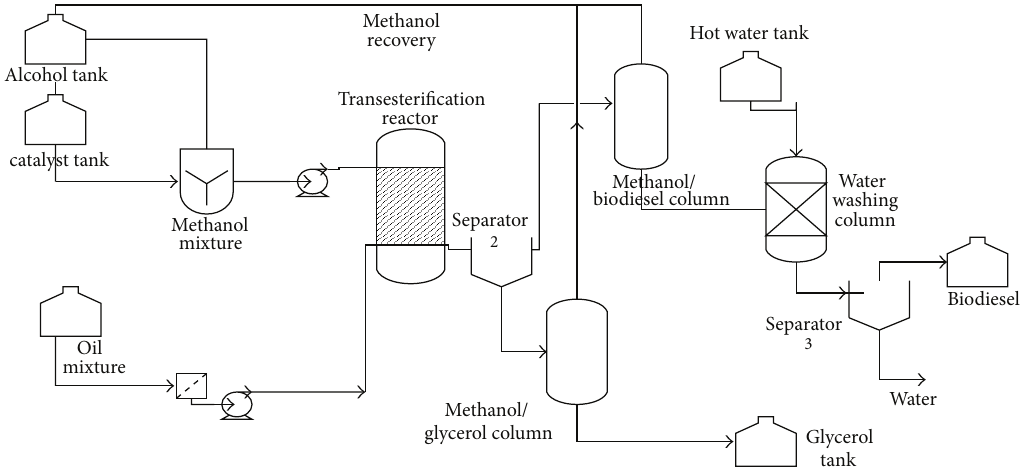
Figure 5: Alkali-catalyzed treatment of pretreated waste cooking oil—process II [70,